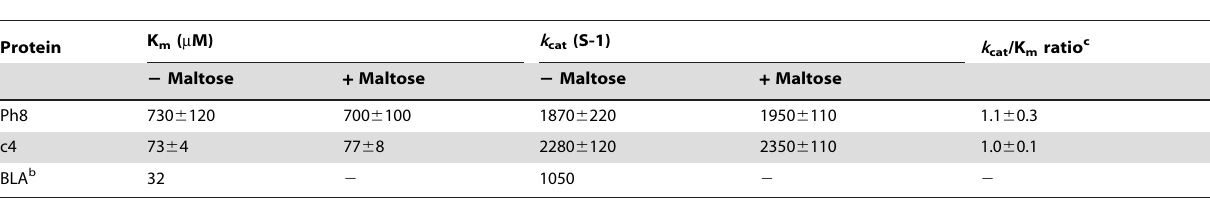
Table 3. Kinetic constants for the hydrolysis of ampicillin a .